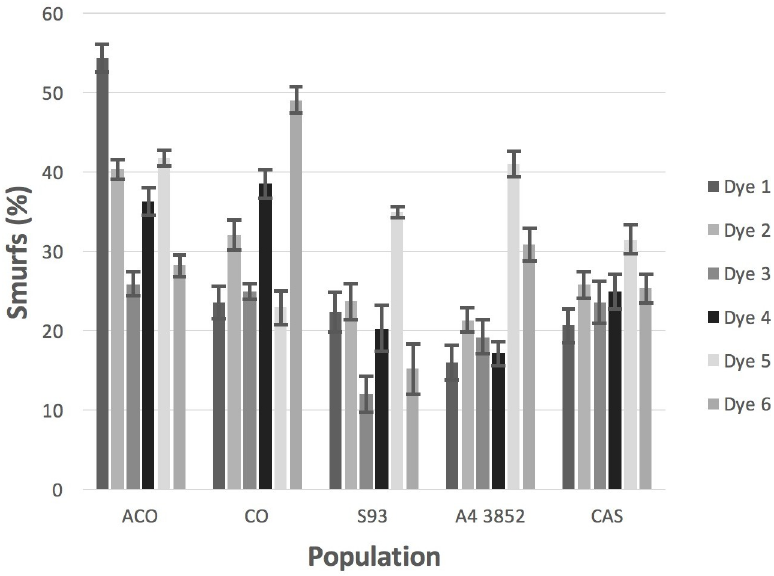
Fig 3. Percentage of flies that became Smurfs for each population and dye. Bars are standard errors.